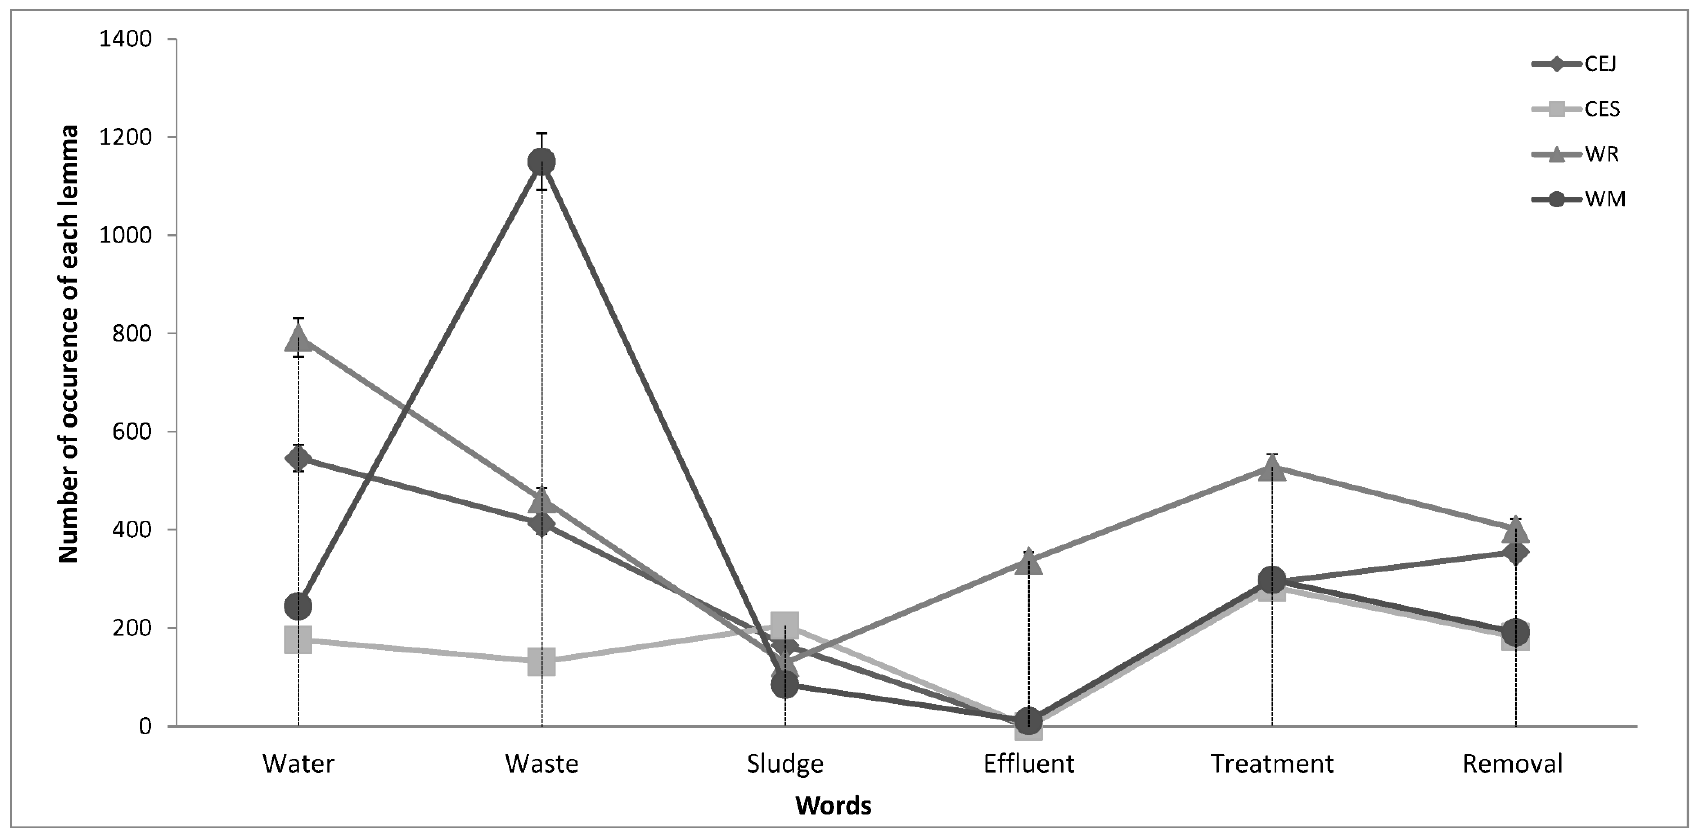
Figure 5. Distribution of the selected keywords among the analysed manuscripts.